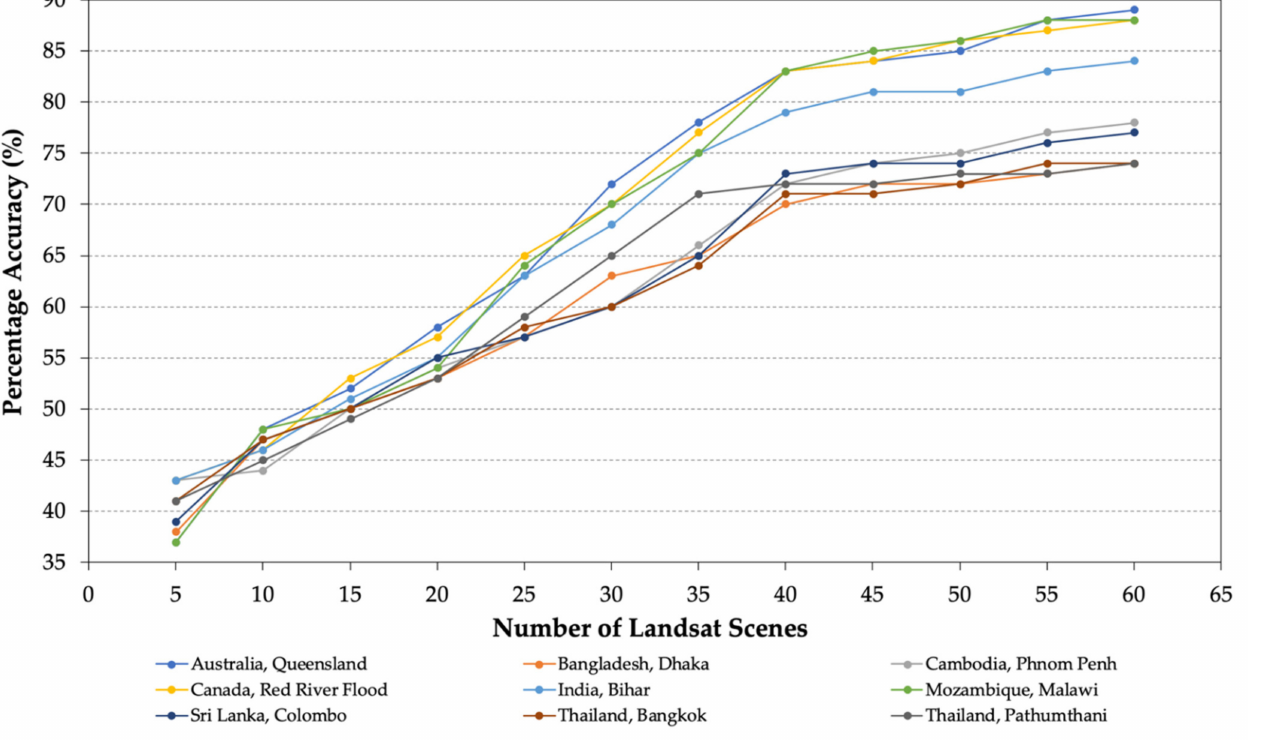
Figure 2. Relationship between the FMA accuracy and number of Landsat scenes used to construct the data